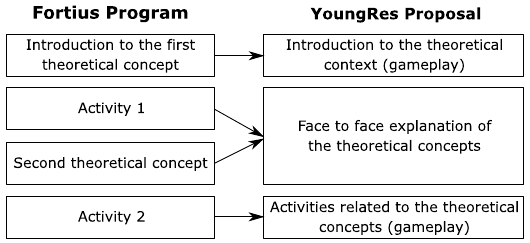
Fig. 1. Adaptation of the Fortius program phases for the inclusion of a video